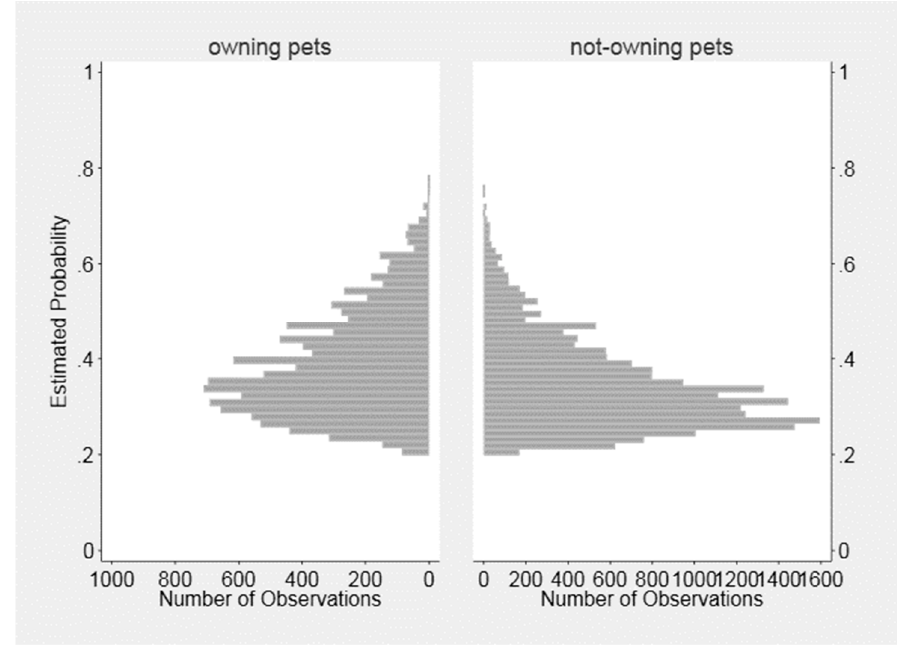
Figure 1. The distribution of propensity score among owning a pet vs. not-owning a pet group.